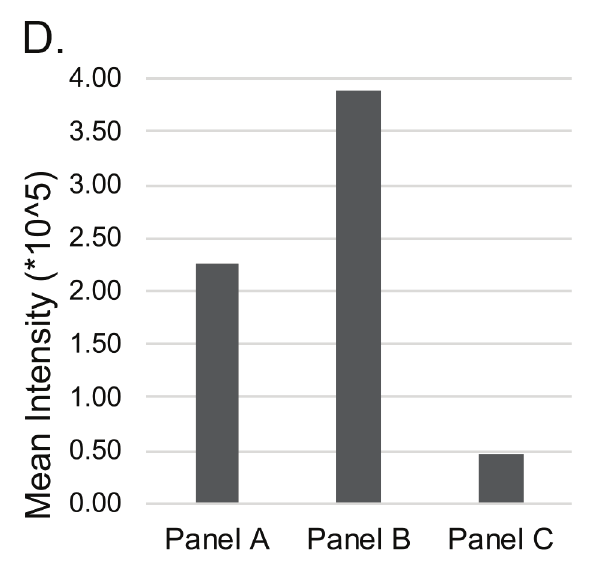
Figure 1. Distribution of bacterial DNA in temporal arteries. Tissue sections were probed with fluores- cently labeled oligonucleotide probes against bacterial DNA (green). Sections were counterstained with DAPI (blue) and Concanavalin A (red) to delineate nuclei and glycoproteins, respectively. Sections were scanned by confocal microscopy. In a control temporal artery (A), bacterial DNA is scattered throughout the media, with select examples highlighted by green arrows. Notably, no/negligible bacterial DNA stain- ing is apparent in the lumen or intima (A, bar graph). The green channel emitted from the internal elastic lamina is a result of autofluorescence. In a temporal artery with histopathological evidence of GCA (B), bacterial DNA is scattered throughout the media and at a higher mean intensity than control (bar graph). Arterial layers are more disorganized and less distinct compared to a control temporal artery, as evidenced by weak autofluorescence and less distinct internal elastic lamina. There is an absence of bacterial DNA at the external edge of a GCA-involved temporal artery specimen (C, bar